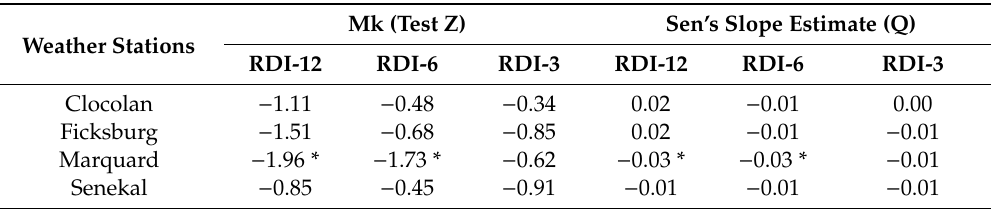
Table 2. The RDI (reconnaissance drought index) trends for di ff erent time scale for the Setsoto municipality from 1985 to 2019. Mann Kendal trend (Test Z) and Sen’s slope estimate